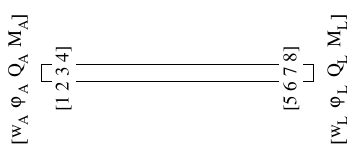
Fig. 3. Indices of state vector components for a beam element.